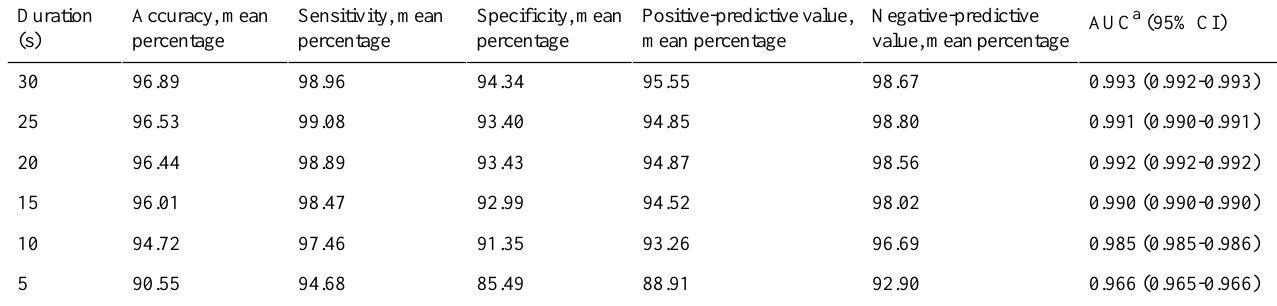
Table 3. Diagnostic performance according to sample